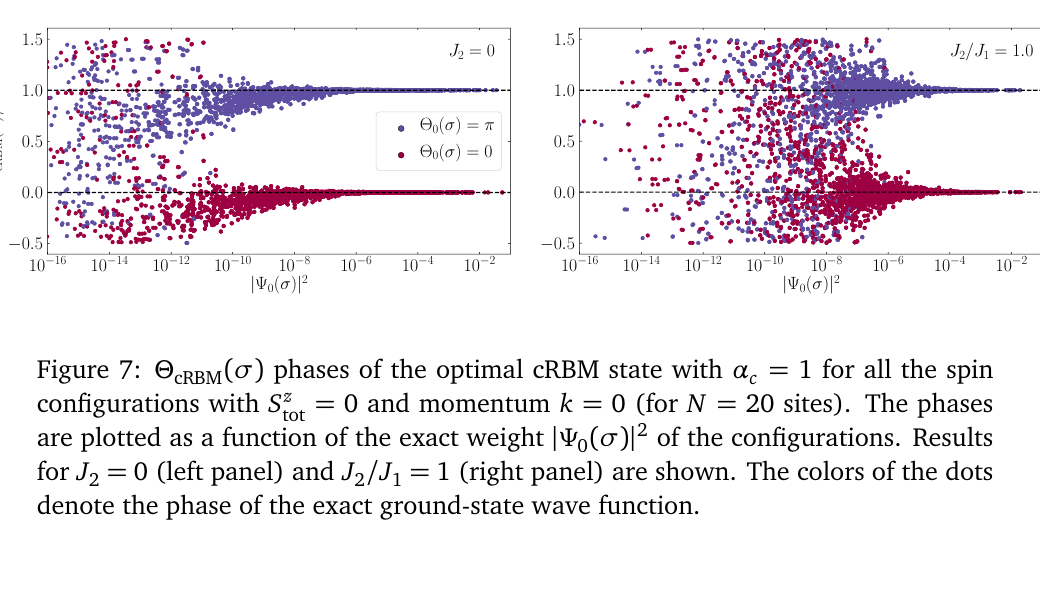
Figure 6: Evolution of the phases Θ during the Monte Carlo optimization for J panel). The colors of the dots denote the phase of the exact ground state wave function. The number of sites is N = 20. The results are plotted as a function of the number of Monte Carlo steps N 10 3 steps.